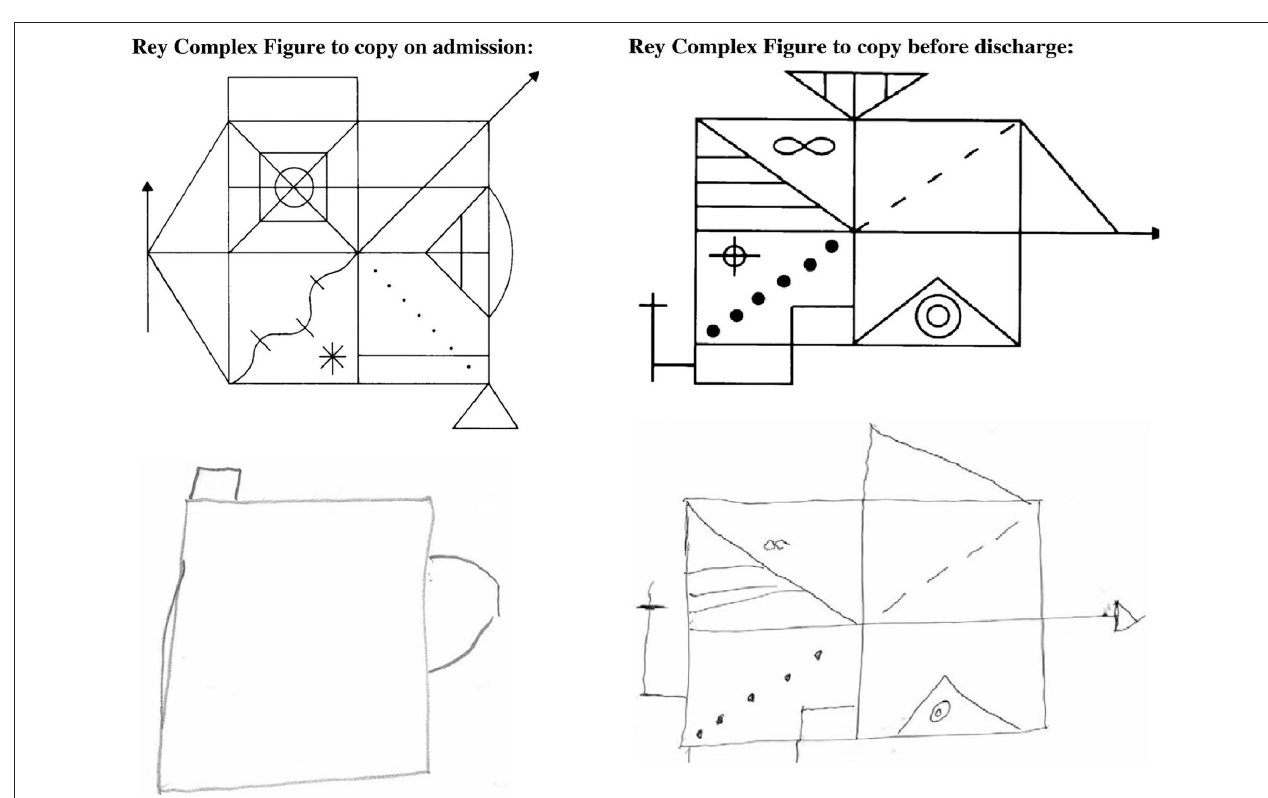
FIGURE 2 | Rey Complex figure testing before and after correction of severe kidney failure. This assessment captures multiple domains of cognitive function including memory, processing speed, and visuospatial construction ability. In this example the admission assessment, performed with a serum creatinine of 2,443 umol/L and blood urea of 67.6 mmol/L is compared to the discharge assessment (creatinine 629 umol/L, urea 17.8 mmol/L). Reproduced from Schneider et al. (10) under the Creative Commons Attribution License.